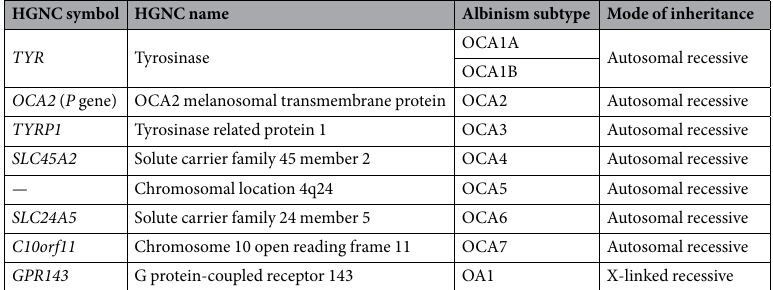
OCA2 ( P gene) OCA2 melanosomal transmembrane protein OCA2